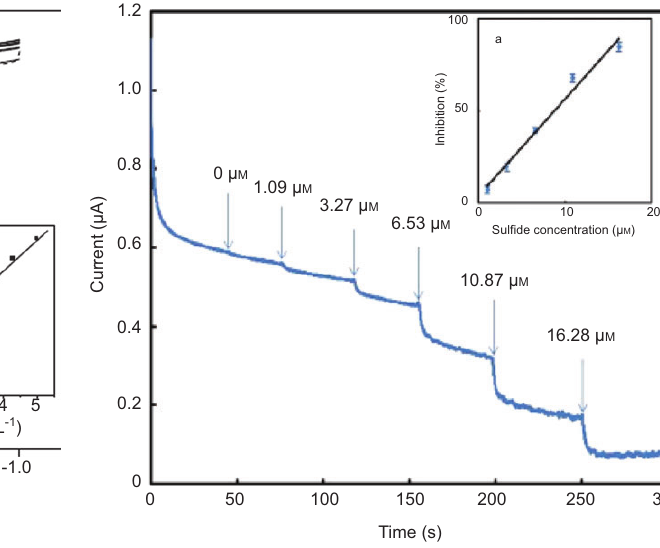
Figure 2 Amperometric response of coprinus cinereus peroxidase (CIP) biosensor for different concentrations of sulfide at -150 mV * C = 0, 0.7, 1.4, 2.2, 2.9, 2- S versus Ag/AgCl in 0.1 m phosphate buffer (pH 6.5) solution contain- ing 0.6 m m H O and 1.25 m m of hydroquinone. Inset (A): calibration 2 2 curve for sulfide determination with CIP inhibition